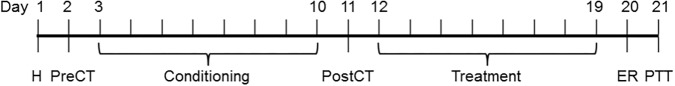
Conditioned place preference (CPP) protocol design. H, habituation; PreCT, drug-free pre-conditioning test; Conditioning, ayahuasca (30, 100, or 300 mg/kg, Experiment 1), Banisteriopsis caapi (132, 440 or 1320 mg/kg, Experiment 2), ethanol (1.8 g/kg, Experiments 5, 6, 7 and 8) – preceded by vehicle or ayahuasca (100 or 300 mg/kg, Experiment 3) or Banisteriopsis caapi (440 or 1320 mg/kg, Experiment 4) pretreatment – or saline conditioning; PostCT, drug-free post-conditioning test; Treatment, vehicle, ayahuasca (100 or 300 mg/kg, Experiments 5 and 6) or Banisteriopsis caapi (440 or 1320 mg/kg, Experiments 7 and 8) treatment in the compartment previously paired with ethanol (Experiments 5 and 7) or saline (Experiments 6 and 8); ER, ethanol (1.8 g/kg) reexposure in previously ethanol-paired compartment; PTT, drug-free post-treatment test.